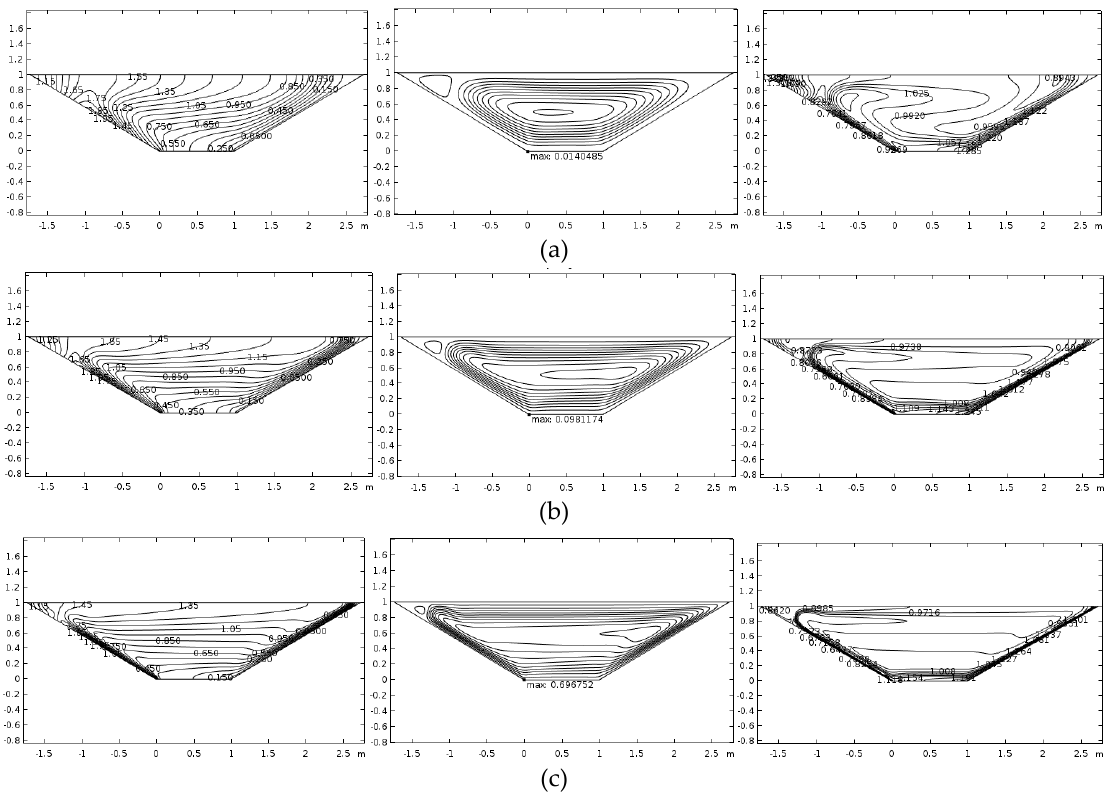
Figure 4. Isotherms, streamlines, and isoconcentration lines for Pr = 7, ϕ = π / 3, κ = 1, ε = 0.5, and ( a ) Ra = 10 4 , ( b ) Ra = 10 5 , ( c ) Ra = 10 6 .